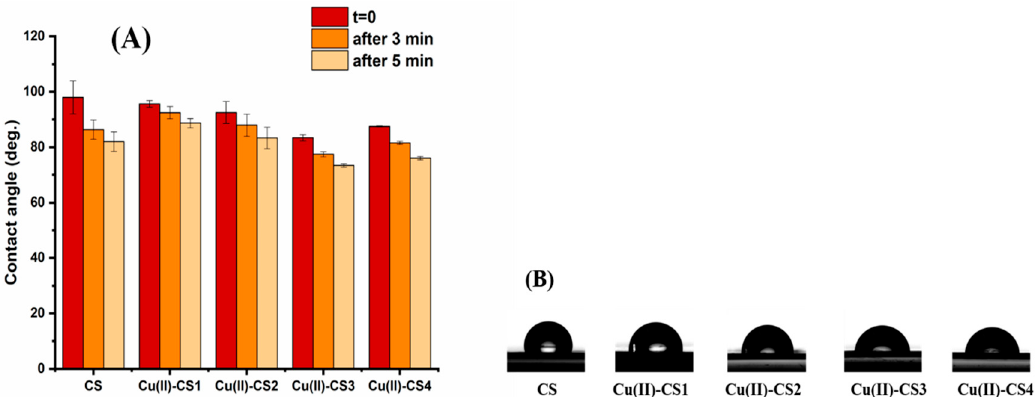
Figure 9. ( A ) Average contact angle of water droplets on CS and Cu(II)–CS coatings measured at three timepoints (i.e., immediately after deposition, after 3 min and 5 min) and ( B ) profiles of water droplets on CS and Cu(II)–CS coatings immediately after deposition.